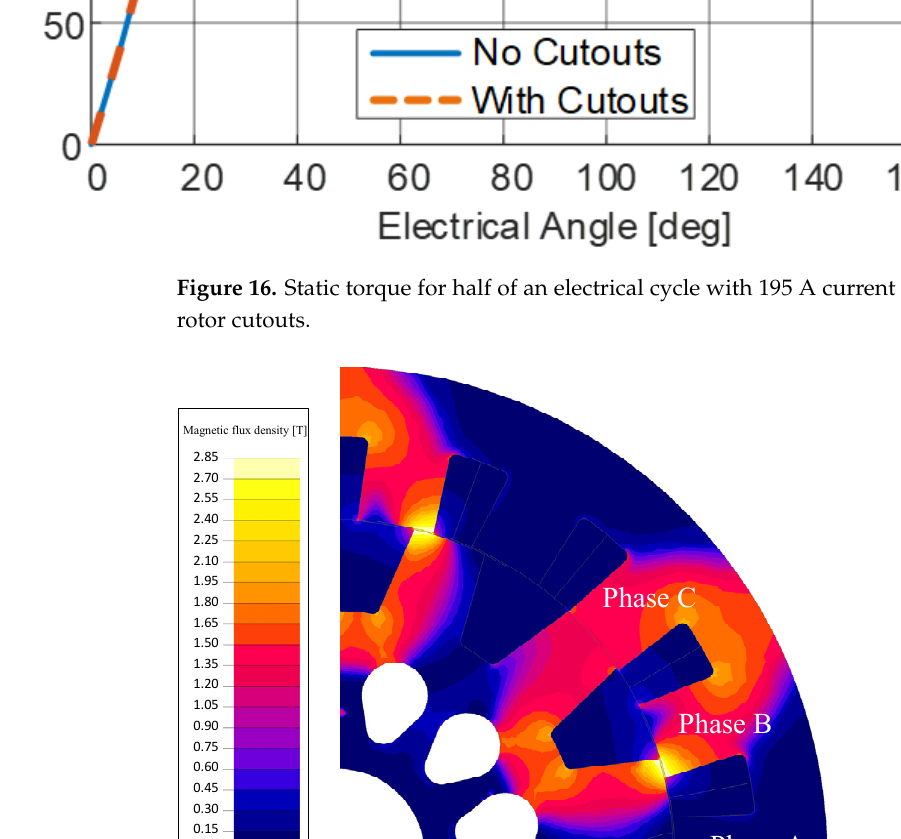
Figure 16. Static torque for half of an electrical cycle with 195 A current reference before and after rotor cutouts.